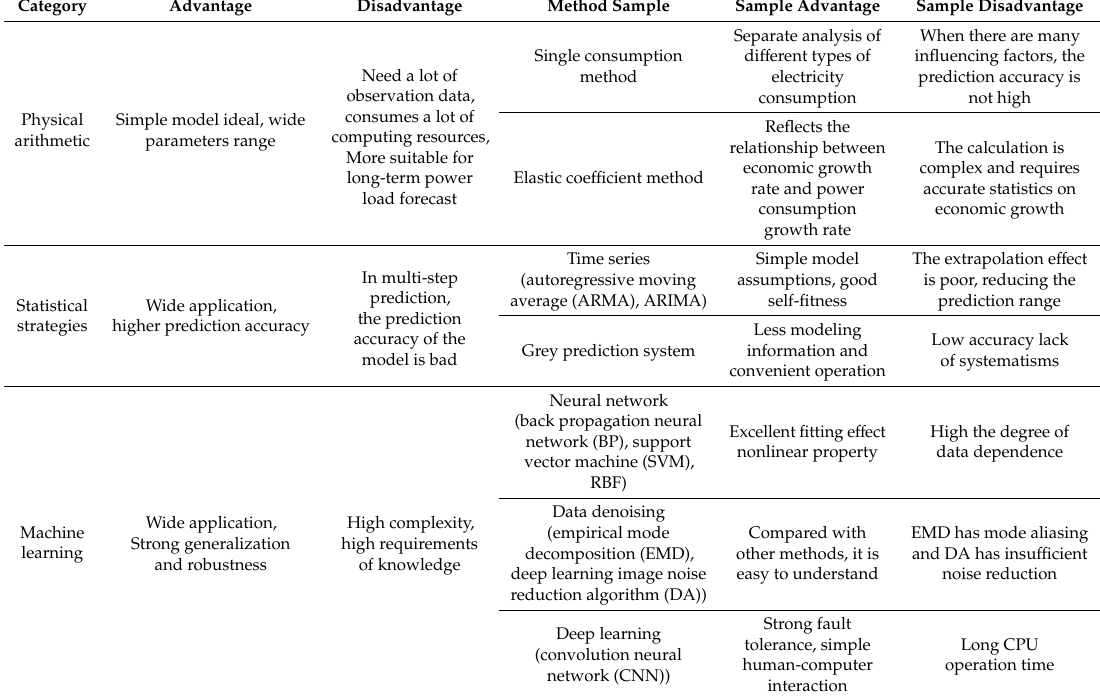
Table 1. Comparison of the advantages and disadvantages of existing power load forecasting